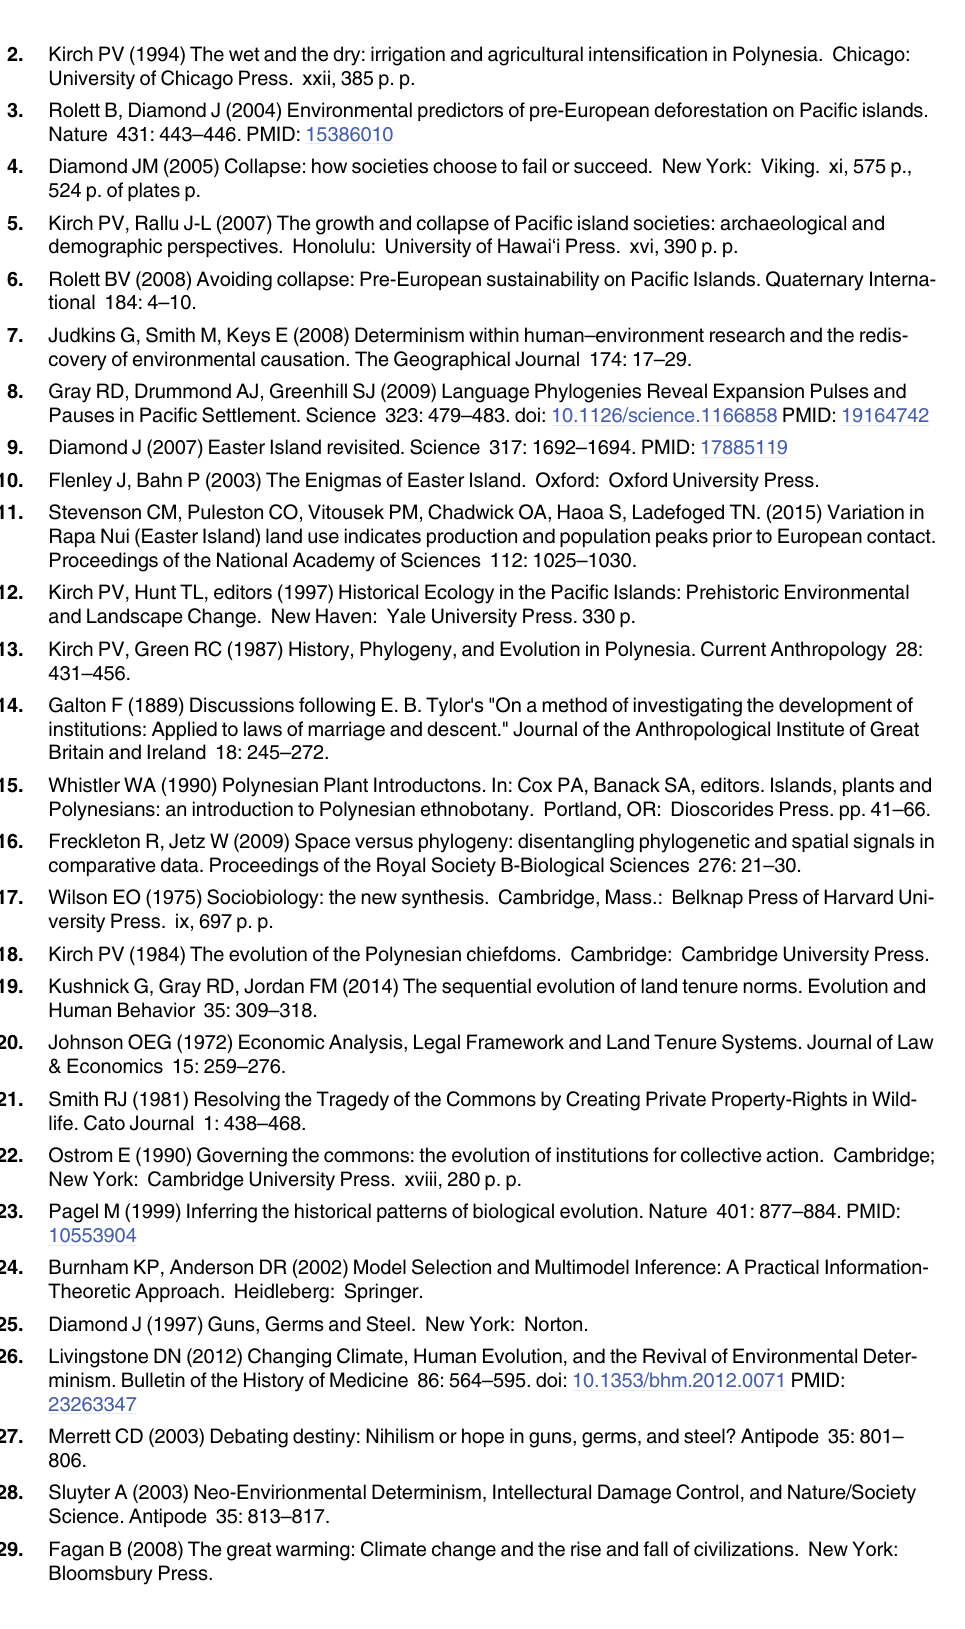
PLOS ONE | DOI:10.1371/journal.pone.0156340 May 27,